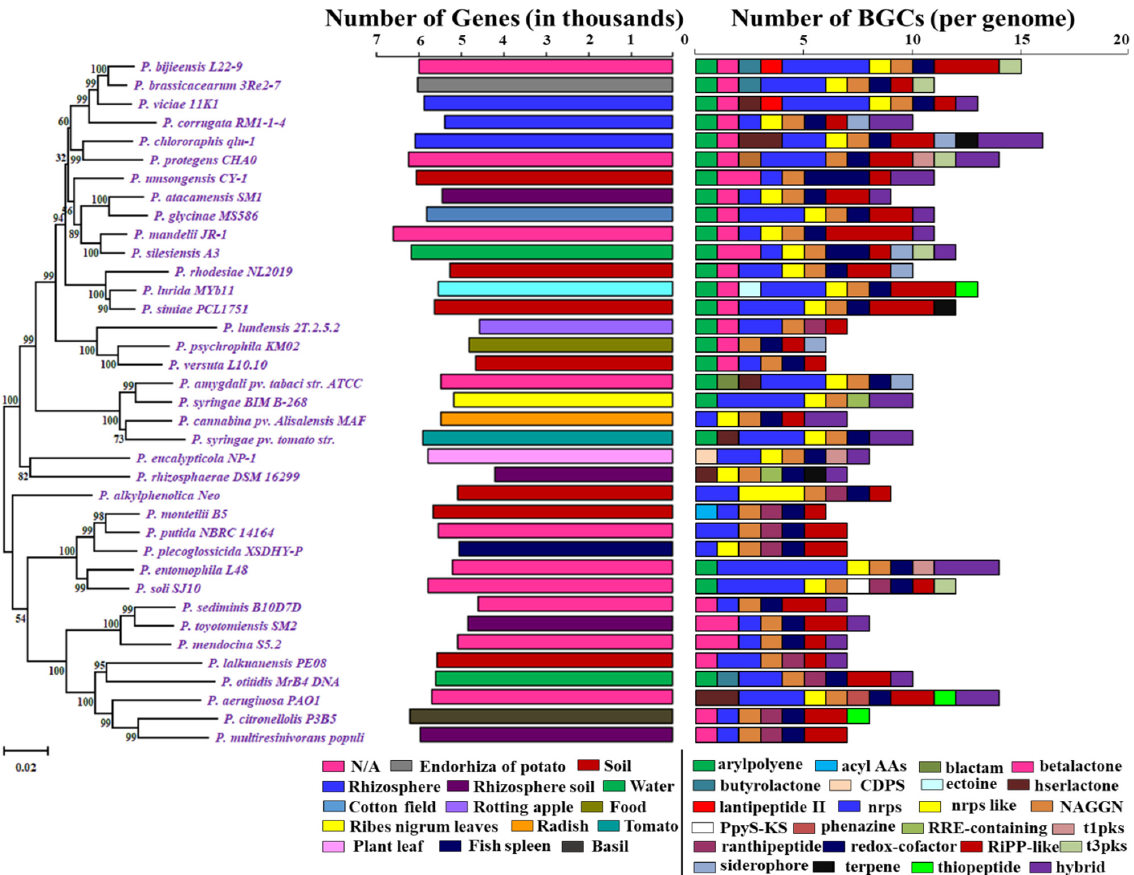
Figure 1. Phylogenetic tree of Pseduomonas along with the gene numbers, isolation sources, and NP BGCs number determined by antiSMASH. The phylogenetic tree is built using rpoB sequences extracted from the genomes based on the maximum likelihood method. Two bar-plots show genome size in thousands of genes on the left, colored by habitats, and the number of BGCs on the right. Species in these two bar-plots keep the same order as the phylogenetic tree. Hybrid clusters are shown separately. The colors matching to habitat types and 24 major NP classes are displayed below the bar-plots. N/A: Not Available